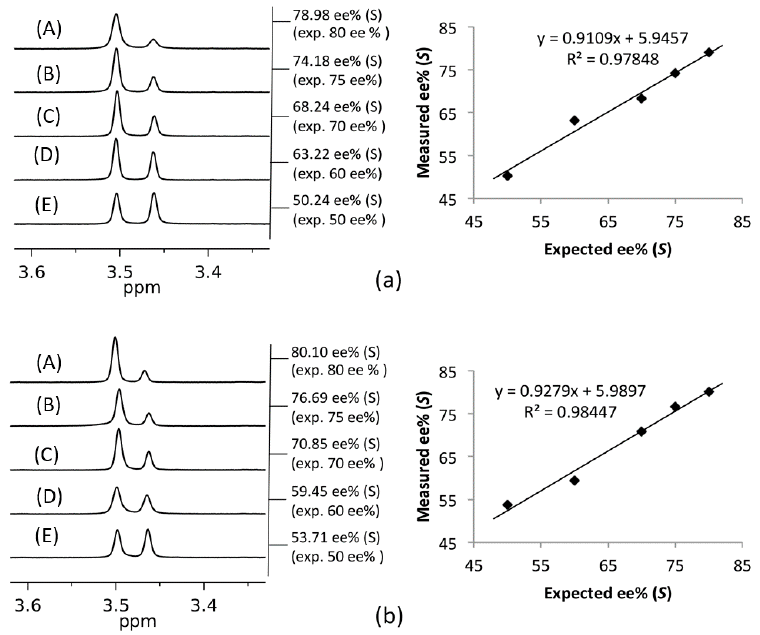
Figure 4. Determination of enantiomeric purities of ( a ) 3 in the presence of 5 and ( b ) 4 in the presence of 6 by 1 H-NMR (500 MHz) in CDCl 3 at 27 °C. (Expected ee% ( S ): (A) 80, (B) 75, (C) 70, (D) 60, (E) 50).